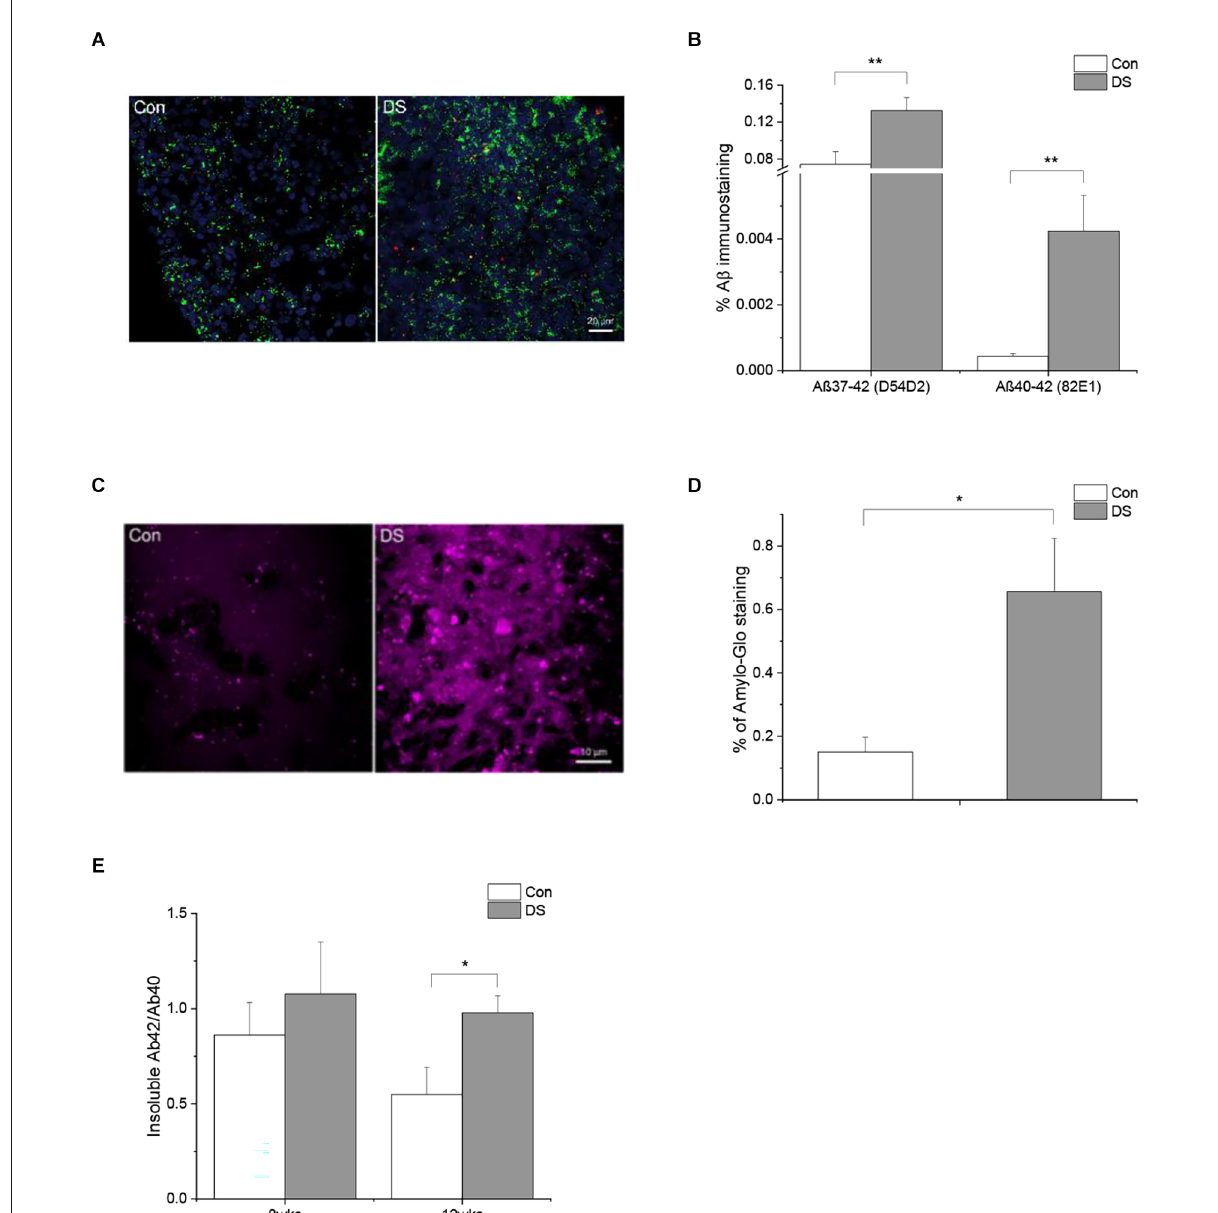
FIGURE3 Abnormal Aß accumulation in DS iPSCs-derived cortical organoids. (A) A representative Aß immunostaining in 12 weeks DS and isogenic control organoids with two different antibodies D54D2 (Aß37-42, green) and 82E1 (Aß40-42, red). (B) Immunohistochemical analysis of Aß antibodies D54D2 and 82E1 revealed a significantly increased Aß immunoreactivity in DS organoids ( n = 10–11, p < 0.01). (C) A representative Aß plaque staining in DS and control organoids using Amylo-Glo. (D) Immunohistochemical analysis of Amylo-Glo revealed a significantly increased amyloid plaque load in DS organoids ( n = 8, p < 0.05). (E) Aß40 and Aß42 in the soluble and insoluble fractions of 8 weeks and 12 weeks DS and control organoids were quantified using Elisa and the ratio of Aß42/Aß40 was significantly increased in the insoluble fractions of 12 weeks DS organoids ( n = 10–11, p < 0.05). * p < 0.05, and ** p < 0.01 vs.